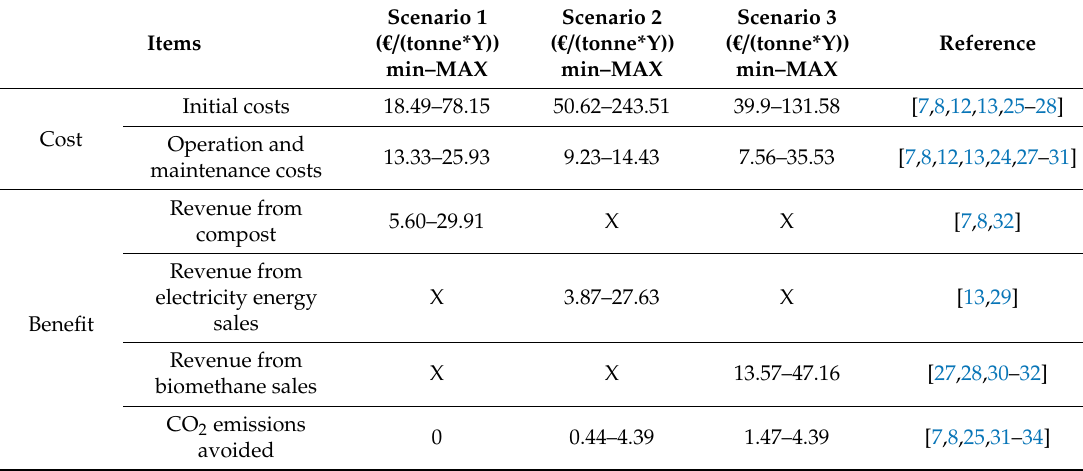
Table 1. Cost and benefit item assessment per scenario